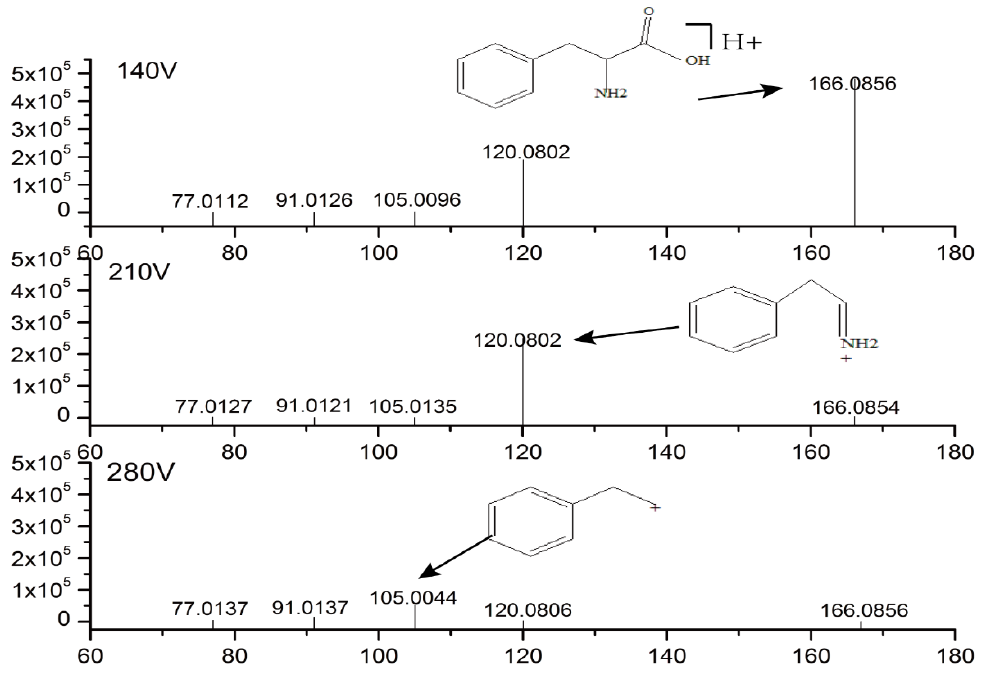
Figure 3. Analysis of phenylalanine structure.